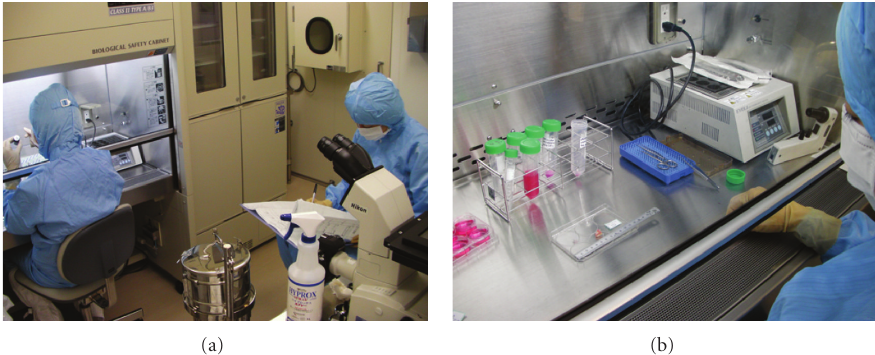
Figure 2: CPC of Tokyo Women’s Medical University. (a) Individuals who work in the CPC wear sterile clothing, gloves, caps, and masks to avoid releasing possible contaminants. (b) All tubes and dishes were labelled to avoid misidentification.